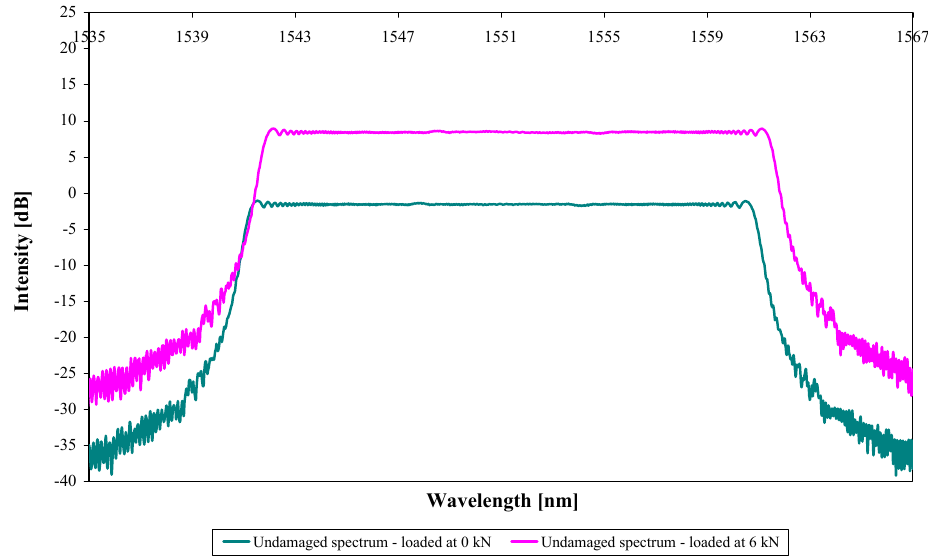
Figure 11. Predicted reflected spectra of the undamaged model when loaded at 0 kN and 6 kN.